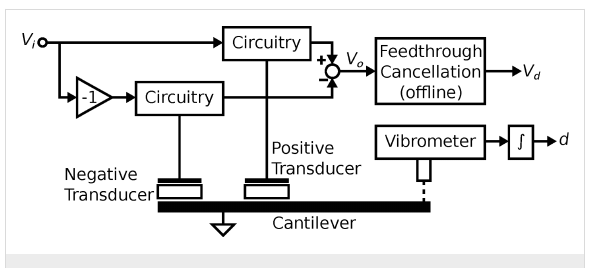
Figure 5: The experimental setup to characterize the cantilever